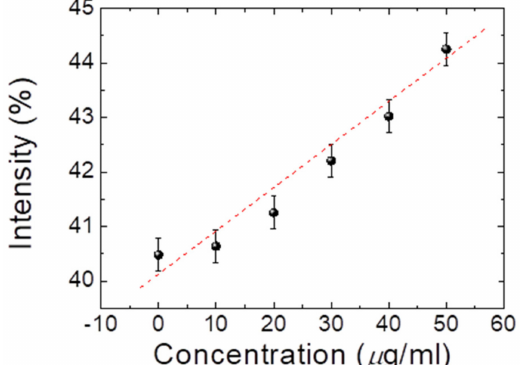
Figure 7. Correlation of light intensity with various cTnI concentrations in CLC biosensing chips with 10 µ g/mL of peptide.